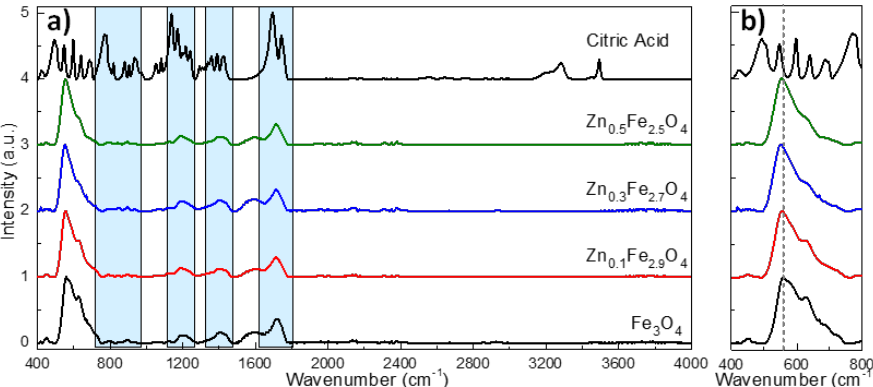
Figure 5. ( a ) FT-IR spectra of citric acid and citric acid coated Zn x Fe 3−x O 4 MNPs (0 ≤ x < 0.5) and ( b ) Zoom in the 400–800 cm −1 region of FT-IR spectra. The spectra are normalized to the highest ( b ) Zoom in the 400–800 cm − 1 region of FT-IR spectra. The spectra are normalized to the highest absorption band and shifted for clarity. absorption band and shifted for